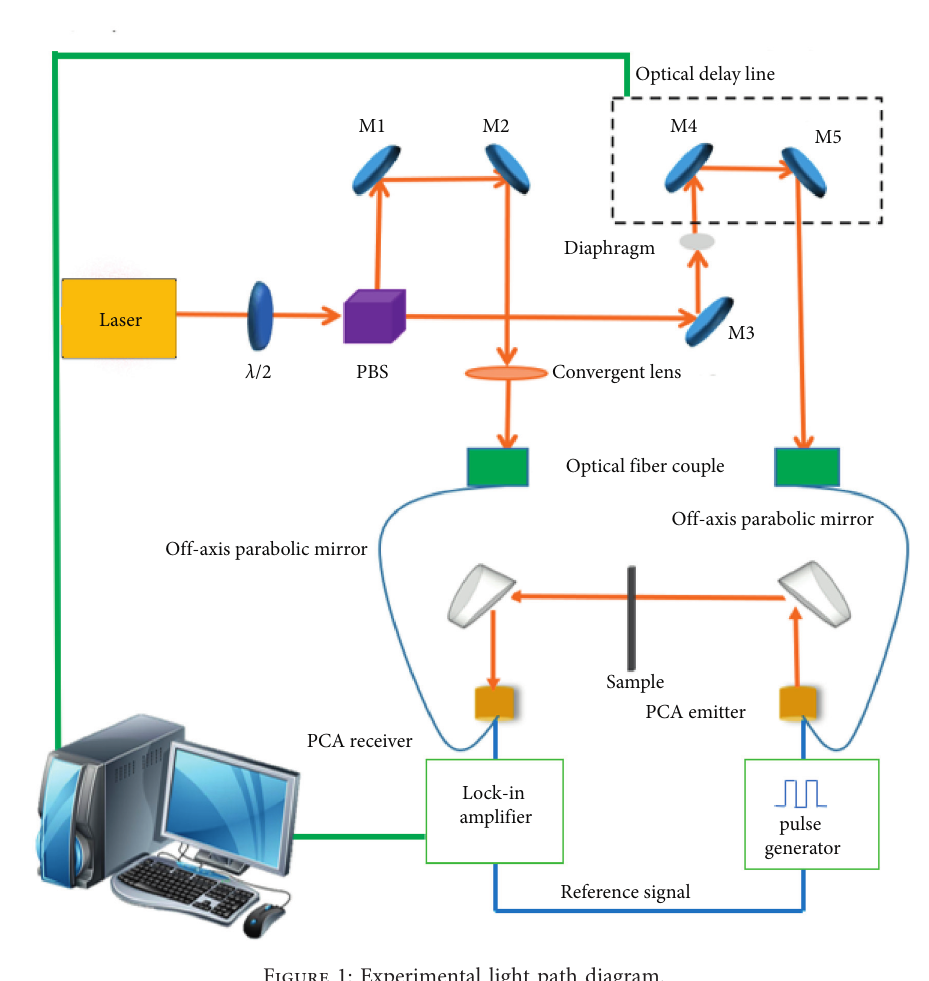
Figure 1: Experimental light path diagram.